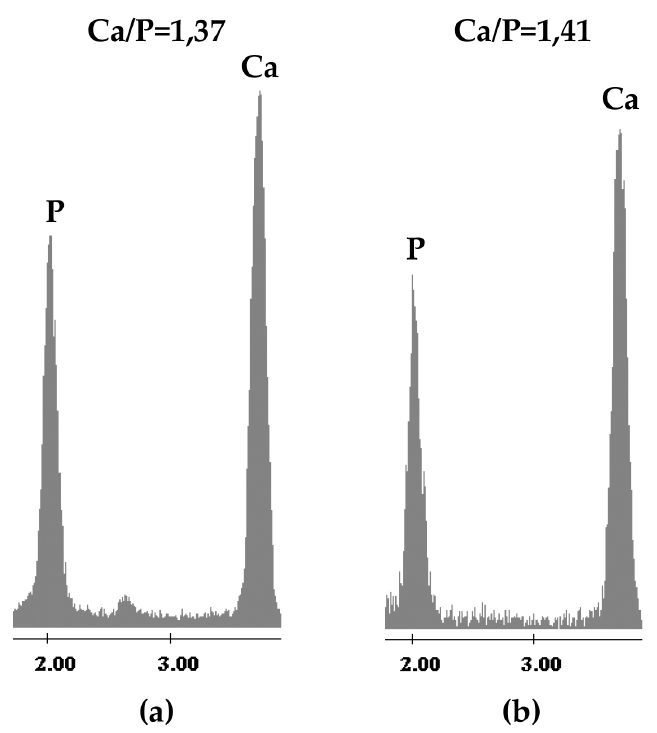
Figure 10. Representative Energy Dispersive X-ray analysis (EDX) images of the globular precipitate on the surface of the samples heated to ( a ) 600 °C and ( b ) 1000 °C after 21 days of exposure to